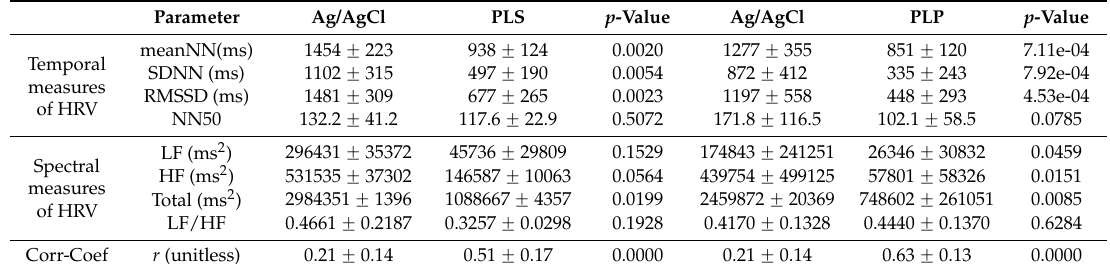
Table 7. Electrocardiogram signal quality—saltwater immersion with movement condition.